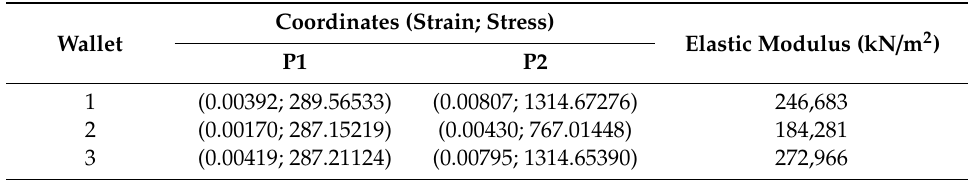
Table 10. Elastic modulus for the wallets, obtained from the linear part of stress–strain curves between Points P1 and P2 [34].